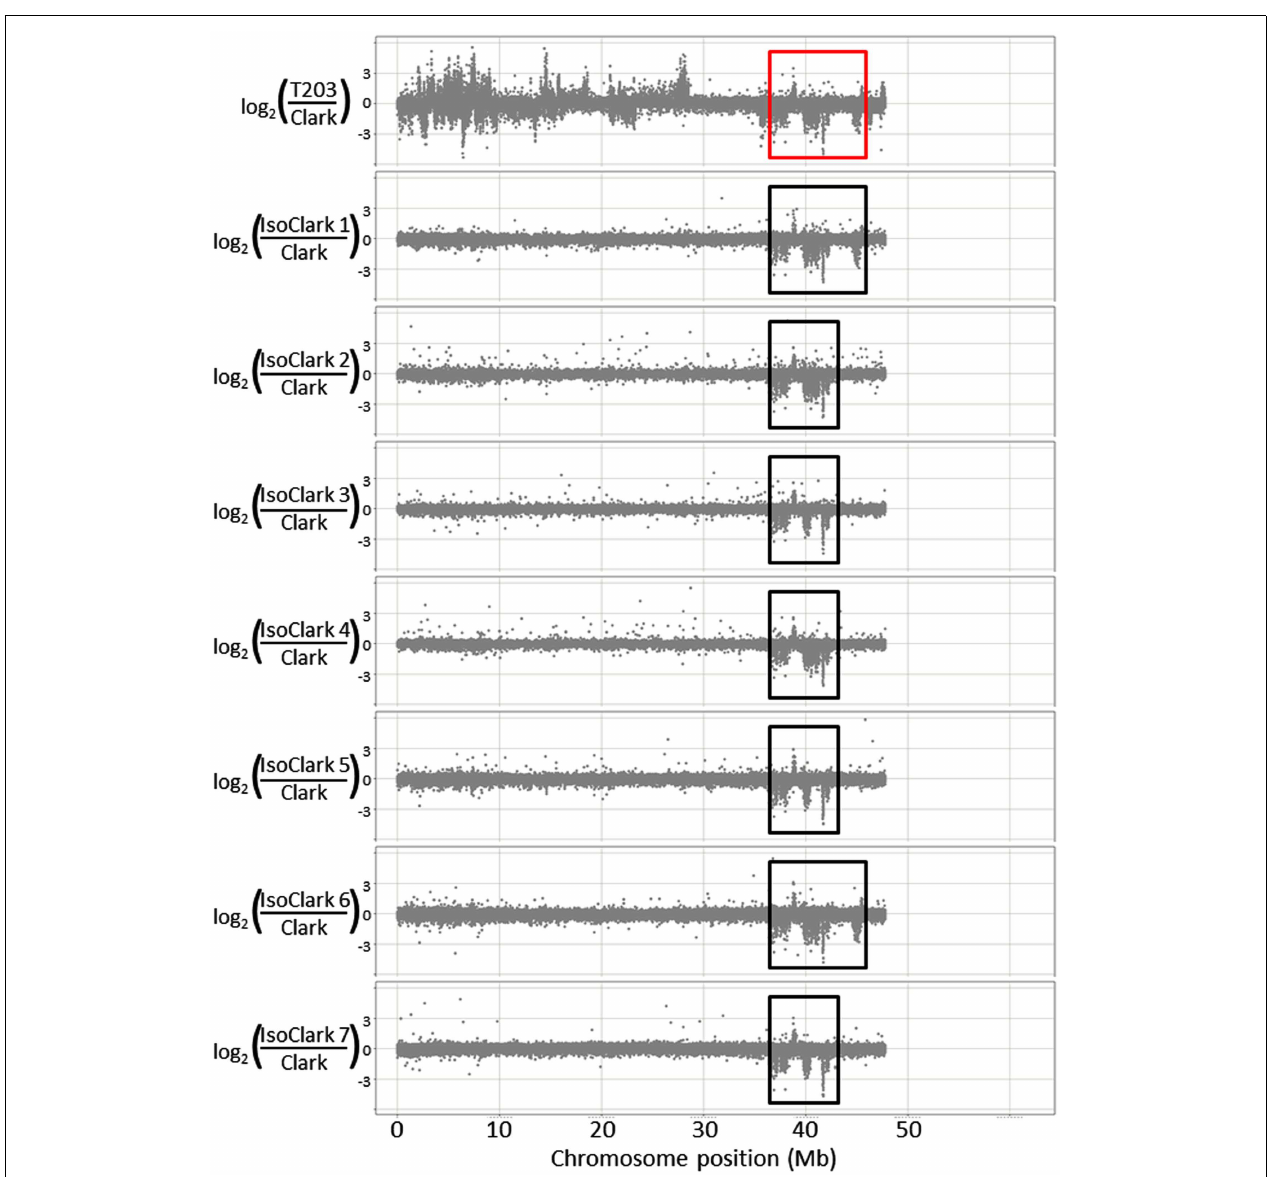
FIGURE 2 | Genomic structural variation on chromosome 03 for seven different “IsoClark”